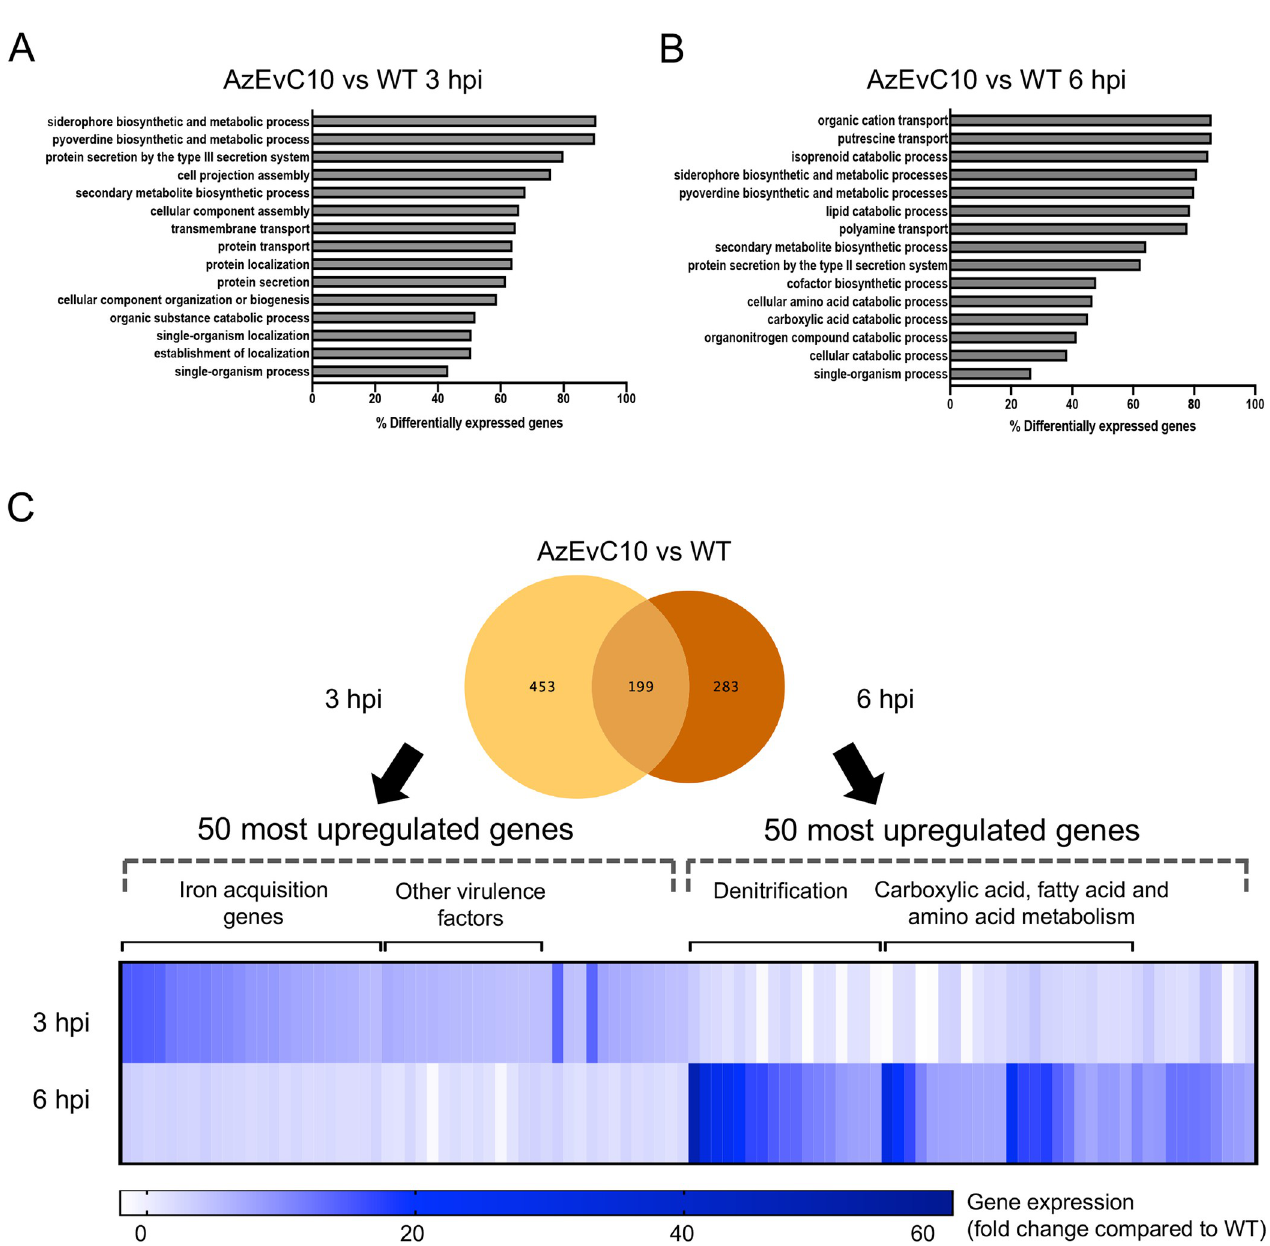
Fig 4. The AzEvC10 mutant upregulates virulence factor expression before metabolic gene expression during macrophage infection. A-B. Gene Ontology Enrichment Analyses reveal distinct enriched biological processes in the AzEvC10 mutant at 3 hpi ( A ) and 6 hpi ( B ). Percentage indicates relative number of genes in each pathway that were differentially regulated. C. Venn Diagram of AzEvC10 mutant DEGs compared to WT PAO1 at 3 hpi and 6 hpi of BMDM. The 50 most upregulated genes at each timepoint were selected and the expression is presented in mean fold-change compared to WT PAO1 (n = 2–5 independent replicates for each